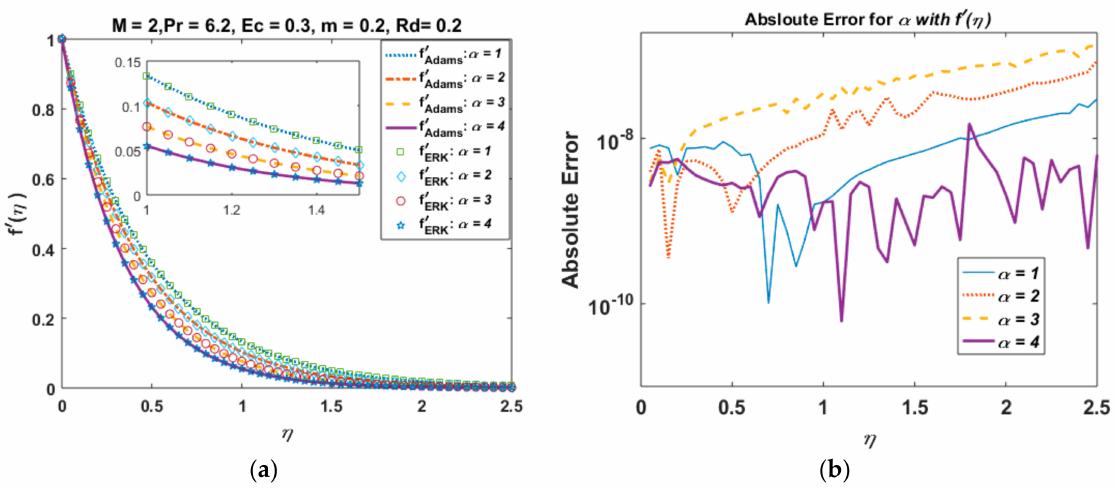
Figure 2. Velocity profile and absolute error for varying values of α . ( a ) Velocity profile with Adam– Bashforth and explicit Runge–Kutta method. ( b ) Absolute error.